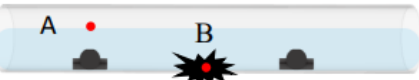
Figure 6. Schematic of broken pipeline with hall sensors and parameters.